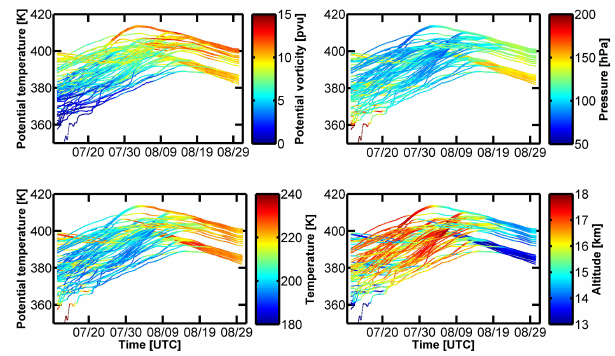
Figure 9. Potential temperature versus time along the trajectory en- semble as shown in Fig. 6. The colour indicates the PV (top left), pressure (top right), temperature (bottom left), and altitude (bottom right) based on ERA-Interim reanalysis data.